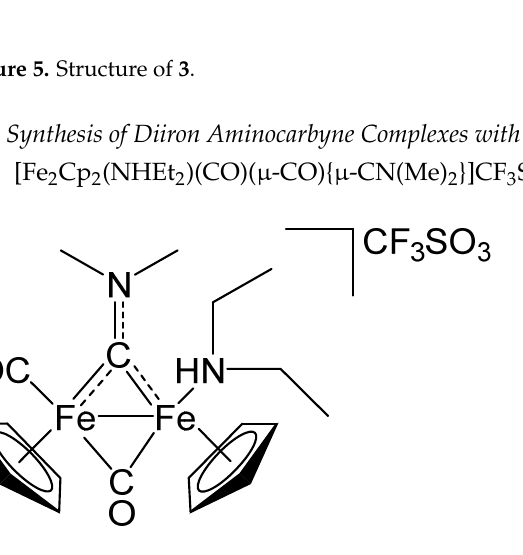
Figure 2. Structure of 2b ( left : α isomer; right : β isomer).